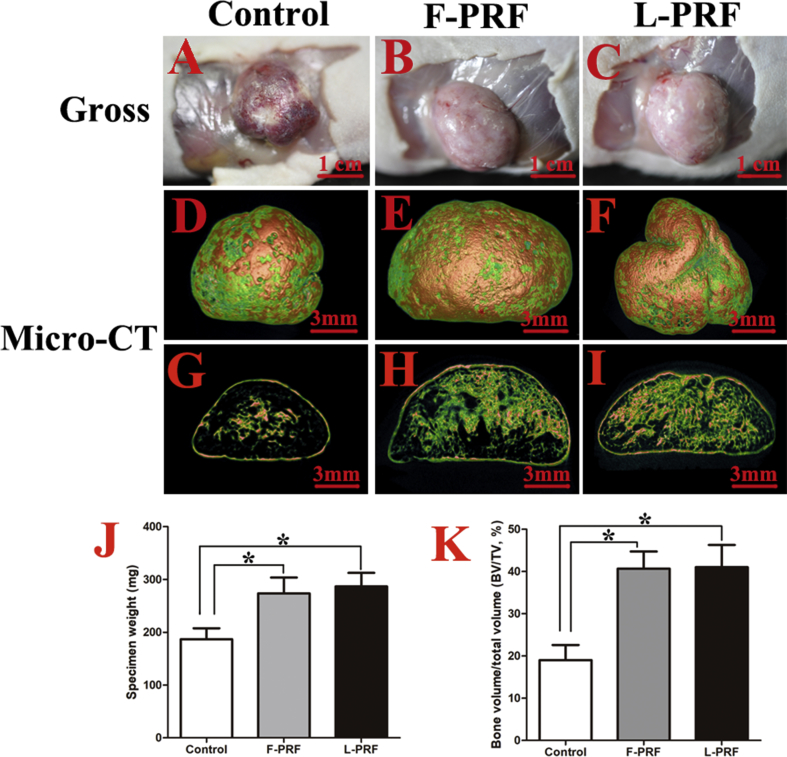
Gross morphology and micro-CT analysis of bone tissue formed in vivo. (A–C) The harvested specimens in the PRF groups were harder than those from the control group (scale bar = 1 cm). (D–F) The micro-CT images showed a mass of deposited minerals in all of the groups, but the spongy bone structure in the control group (D) was much sparser than that observed in the F-PRF (E) and L-PRF (F) groups (scale bar = 3 mm). (G–I) Cross sections of the micro-CT images also showed that there was substantially more newly formed bone-like tissue in the F-PRF (H) and L-PRF (I) groups than in the control group (G) (scale bar = 3 mm). (J) A comparison of specimen weights between the groups. The average weight of the specimens in the control group was 186.7 ± 22.5 mg, which was significantly less than that observed in the F-PRF (273.3 ± 31.6 mg) and L-PRF (286.7 ± 29.5 mg) groups (P = 0.01), with no significant difference observed between the F-PRF and L-PRF groups (P = 0.14). (K) The three-dimensional bone volume to total volume (BV/TV) ratios indicated significant differences in the amount of newly formed bone between the control and PRF groups (P = 0.01). Specifically, the BV/TV in the F-PRF and L-PRF groups was 40.3 ± 5.5 and 41.4 ± 6.8%, respectively, which was notably greater than that observed in the control group (19.1 ± 2.5%) (*P < 0.05).